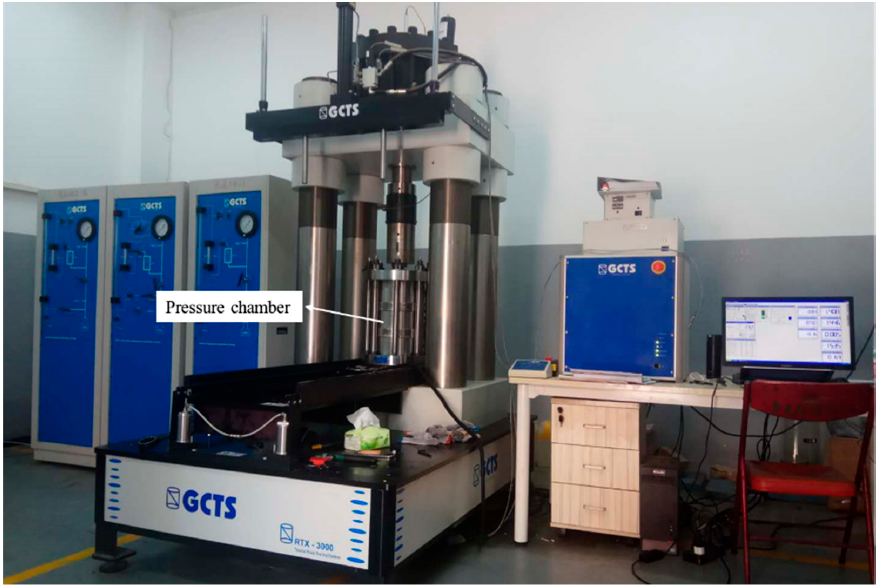
Figure 3. GCTS RTX-3000 triaxial rock testing